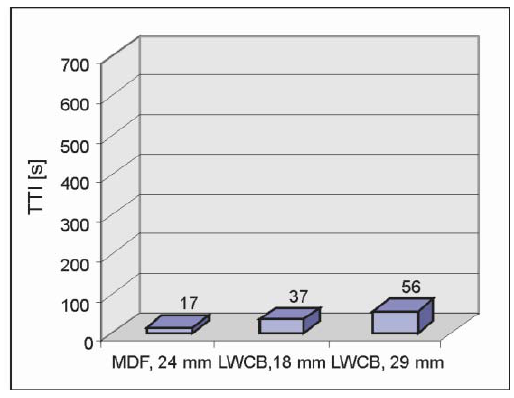
Fig. 3. Mean time to ignition (TTI) when exposed to the surface heat flow density of 50 kW/m 2 for different tested boards